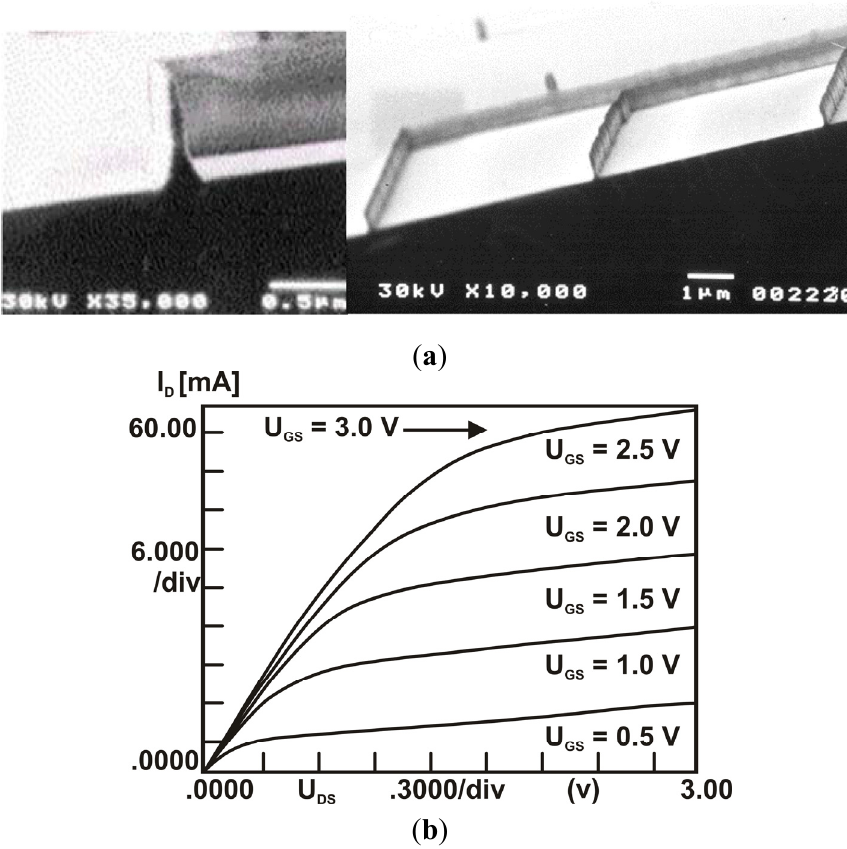
Figure 4. ( a ) Example of structures fabricated using the SWEB technique on silicon bulk and polycrystalline Si on SiO 2 ; ( b ) electrical characteristic of a MOSFET integrated by SWEB with L = 70 nm and W = 300 μ m. © 2015 IEEE. Reprinted, with permission, from